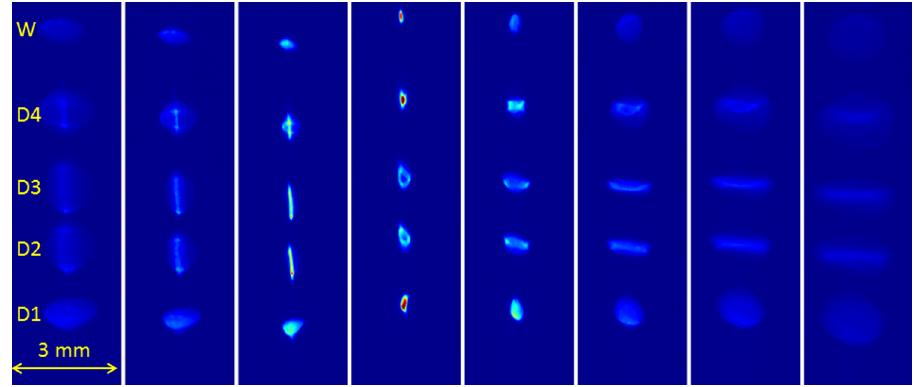
FIG. 13. Images of the bunch train on the screen (Flag U3) during the quadrupole scan from the No. 170652